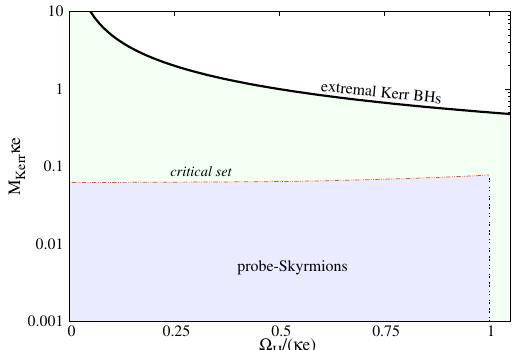
Figure 4 . The domain of existence of Skerrmions in a Kerr BH mass vs: horizon angular velocity diagram.